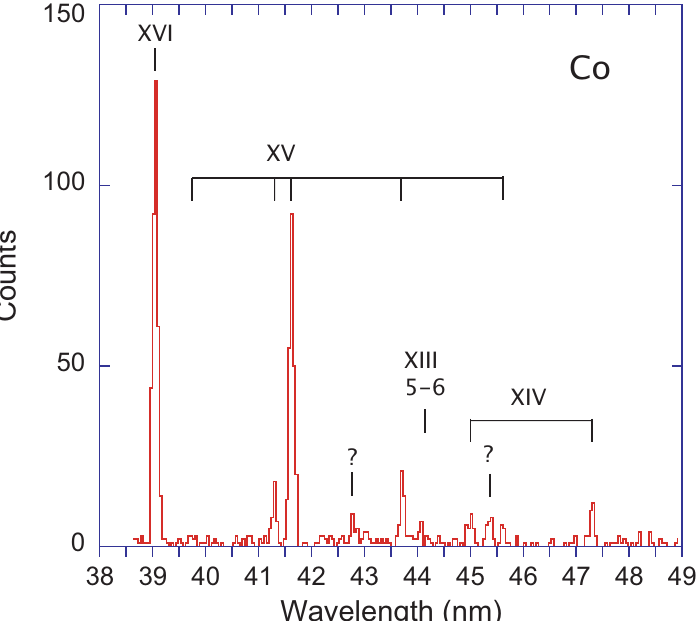
Figure 22. Beam-foil spectrum of Co at an ion beam energy of 28MeV. Observation 175mm down- stream of the foil (delay 18ns). Line width (FWHM) 0.12nm. The strongest lines (from the inter- combination decays 3s 2 1 S 0 –3s3p 3 P o , 3s 2 3p 2 P o –3s3p 2 4 P 1/2,3/2,5/2 and 3s 2 3p 2 3 P 1,2 –3s3p 3 5 S o 1 1/2,3/2 respectively, in Mg-, Al- and Si-like ions) are identified by the spectrum